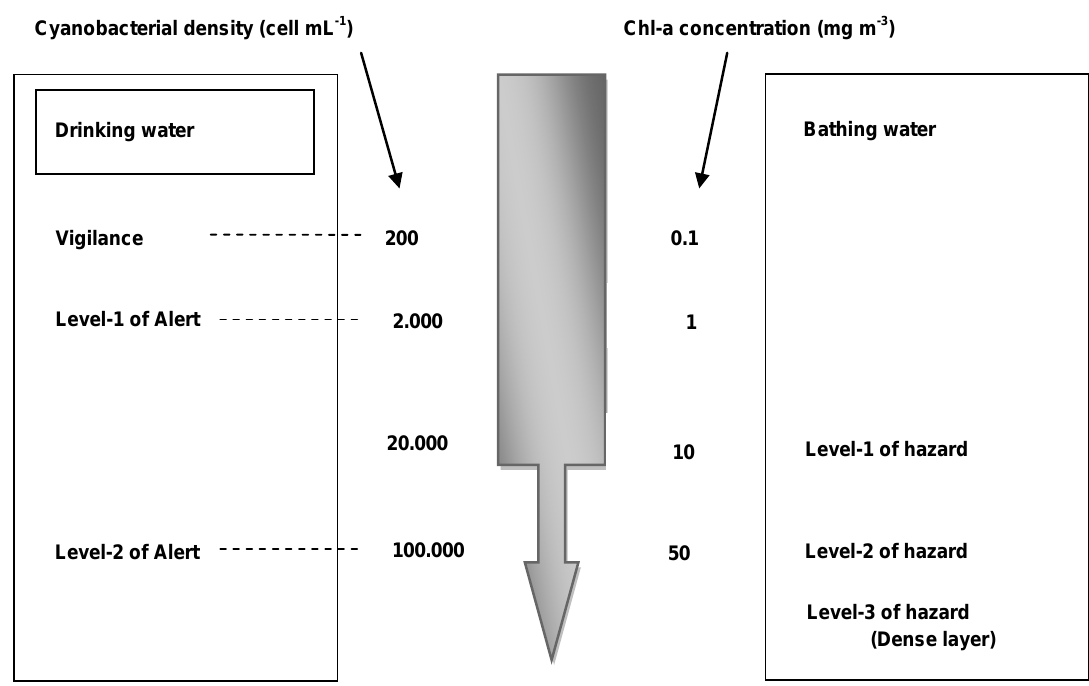
Figure 8. Chlorophyll-a concentration and cyanobacterial density used in decision tree published by the World Health